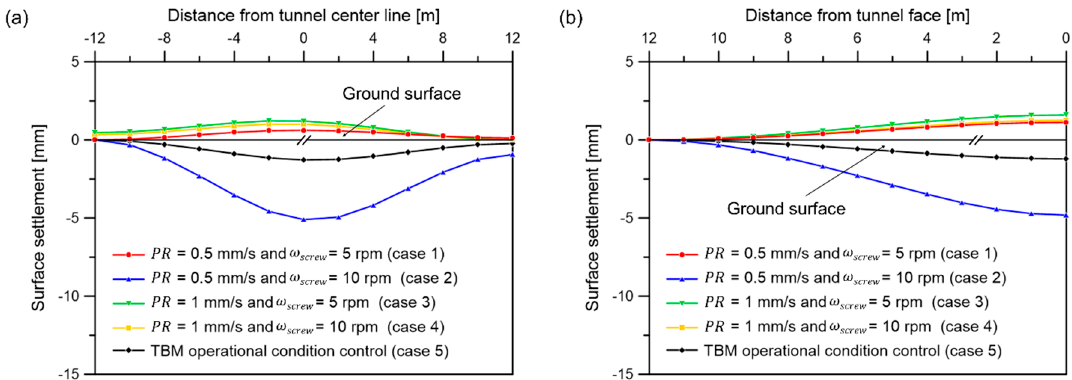
Figure 16. Comparison of surface settlement after the EPB shield has advanced 300 mm: ( a ) transverse settlement trough; ( b ) longitudinal settlement trough.